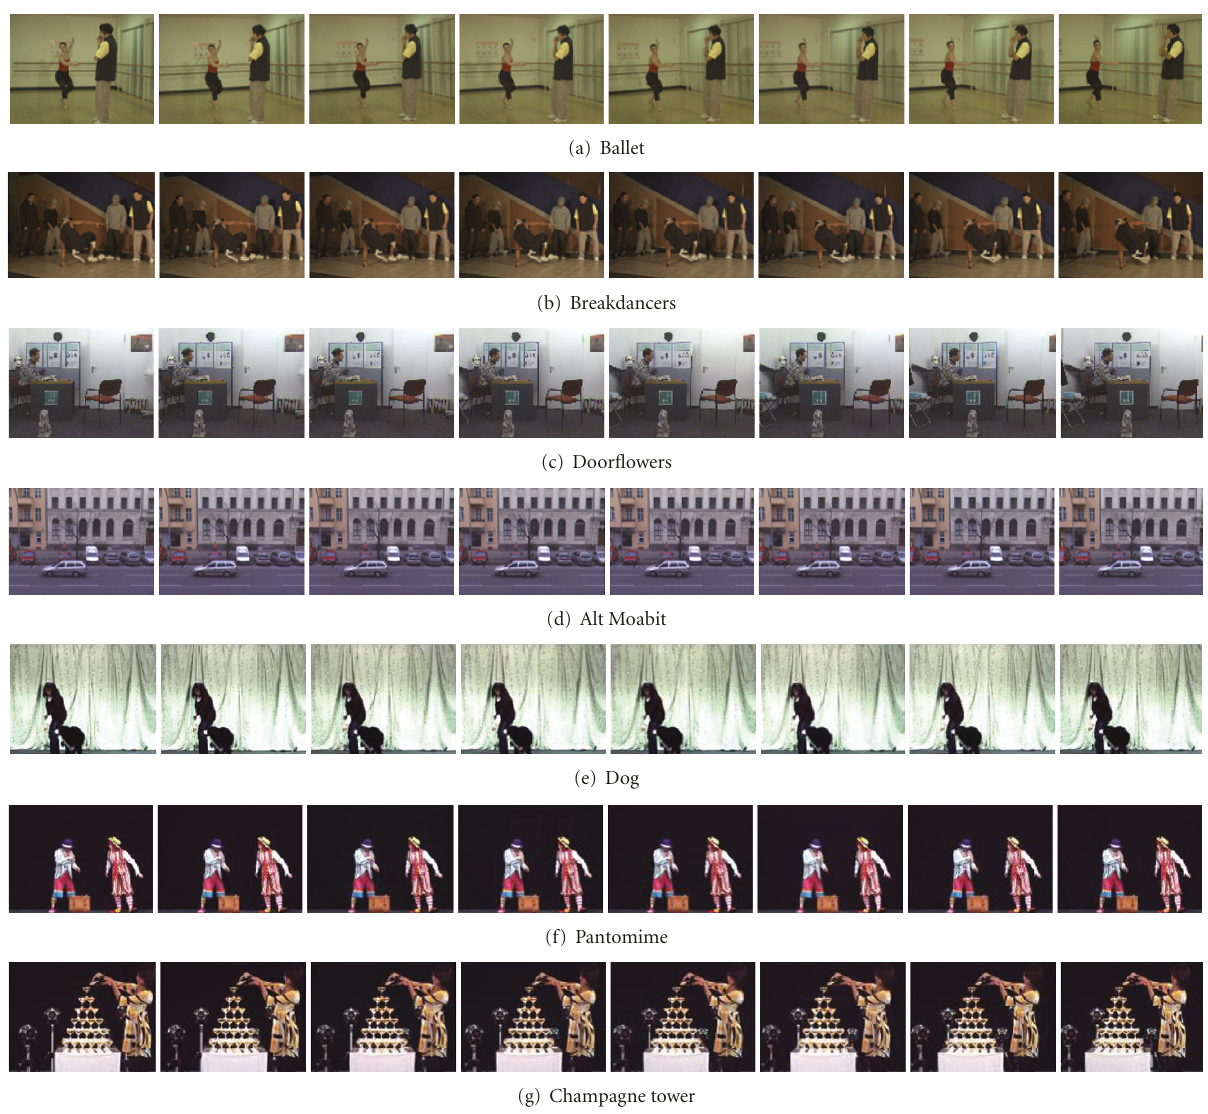
Figure 6: Eight views of multiview video test